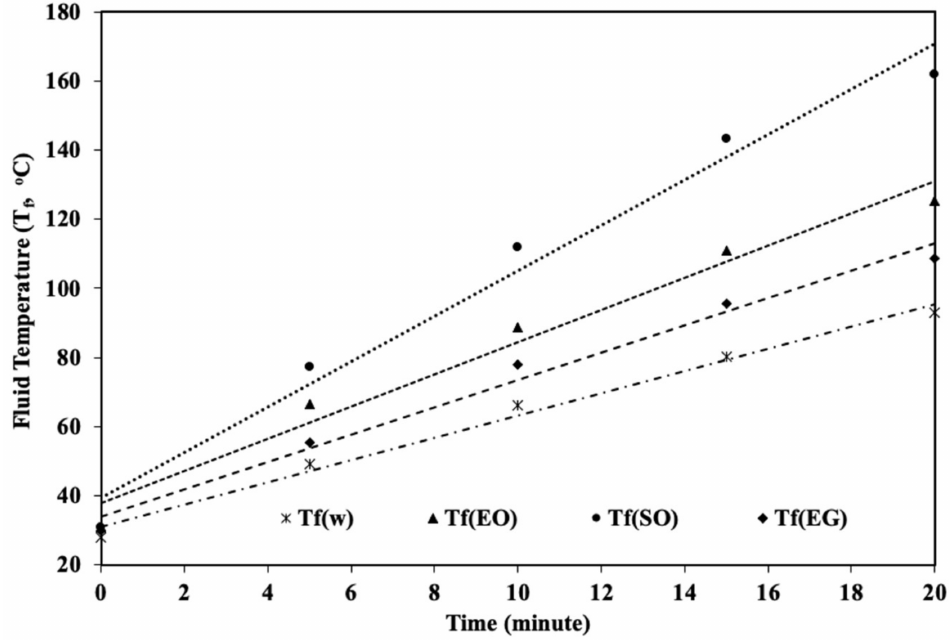
Figure 6. Heating curves of HTFs in transient state (EO 15 November, EG 17 November, SO 20 November and water 23 November